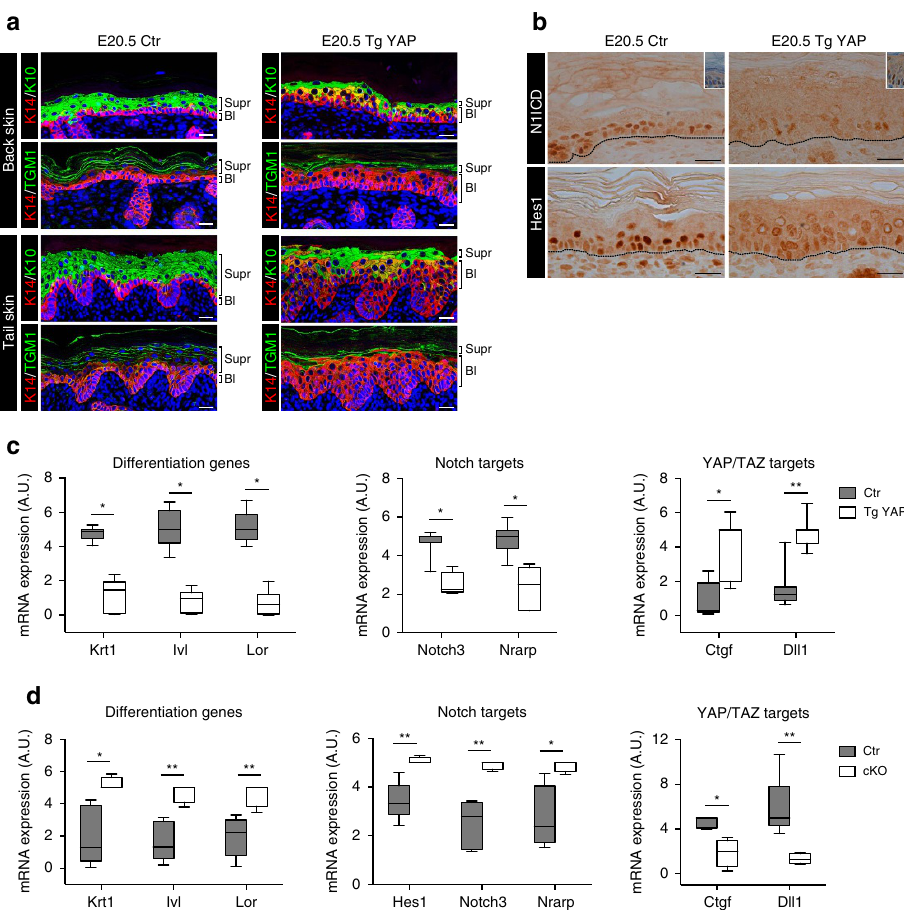
Figure 6 | In vivo validation of YAP/TAZ as inhibitors of Notch signalling in epidermis. ( a – c ) YAP induction inhibits epidermal differentiation and Notch signalling in vivo . ( a ) YAP overexpression in YAP-transgenic (Tg YAP) mice leads to the expansion of the basal layer and diminished terminal differentiation. IF on the back and tail skin of E20.5 embryos reveals increased thickness of the KRT14-positive basal layers (Bl) with concomitant reduction of the differentiated KRT10- and TGM1-positive suprabasal layers (Supr) compared to control littermates (Ctr). K14, keratin 14; K10, keratin 10. Scale bar: 20 m m. See also Supplementary Fig. 4a for additional data at E18.5. ( b ) YAP inhibits Notch signalling in epidermis. Immunohistochemistry on the back skin of Tg YAP at E20.5 embryos shows decreased Notch signalling in the epidermis compared to control littermates (Ctr), as visualized by the greatly reduced levels of the N1ICD fragment (top panel) and Hes1 (bottom panel). The insets (0.5 (cid:2) ) show immunohistochemistry for Yap and nuclear counterstaining in Ctr and Tg YAP mice, as control of YAP overexpression. Scale bar: 20 m m. ( c ) qRT–PCR on skin biopsies of mice as in a , b . YAP overexpression inhibits the expression of both terminal differentiation markers of epidermis ( Krt1 , Ivl , Lor ) and Notch transcriptional targets ( Notch3 , Nrarp ), while it upregulates the YAP/TAZ target genes ( Ctgf , Dll1 ). Relative mRNA expression values were normalized to an internal sample for each experiment and represented in arbitrary units (A.U.) as box plots ( n ¼ 8 for Ctr and n ¼ 7 for Tg YAP, from three independent experiments. * P o 0.0001, ** P o 0.01 compared to Ctr; Student’s t -test). ( d ) YAP/TAZ double conditional knockout (cKO) induces terminal differentiation and Notch signalling in vivo . qRT–PCR analysis on the epidermis from E17.5 embryos shows an upregulation of both the terminal differentiation markers ( Krt1 , Ivl , Lor ) and Notch transcriptional targets ( Hes1 , Notch3 , Nrarp ) in Yap/Taz cKO mice compared to controls (Ctr). The reduced YAP/TAZ transcriptional activity in cKO embryos is confirmed by the dowregulation of the target genes Ctgf and Dll1 . Relative mRNA expression values were normalized to an internal sample for each experiment and represented in A.U. as box plots ( n ¼ 5 for Ctr and n ¼ 4 for cKO, from three independent experiments. * P o 0.05, ** P o 0.01 compared to Ctr; Student’s t -test). Box plots in c , d show the median, interquartile range, minimum and maximum